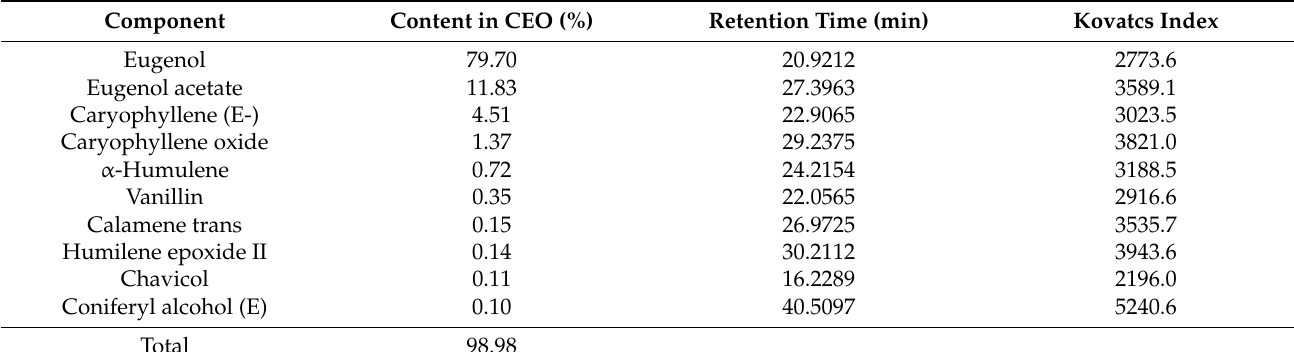
Table 2. Chemical compositions of CEO obtained by GC-MS